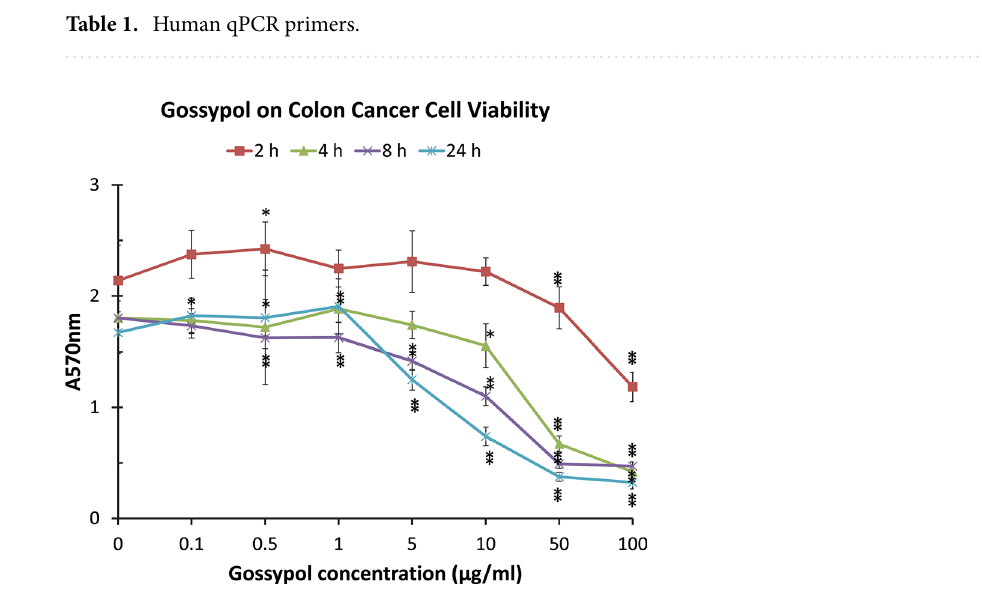
Figure 2. Effect of gossypol on human colon cancer cell viability. Human colon cancer cells (COLO 225) were treated with various concentrations of gossypol for 2, 4, 8 and 24 h. The cell media were added with MTT assay reagent, and incubated for 2 h before adding MTT solubilization solution, shaken at room temperature overnight. “0 µg/mL” treatment corresponding to 1% DMSO in the culture medium, the vehicle control for the experiment. The color density in the wells was recorded at A570. The data represent the mean and standard deviation of 12 independent samples. “*” and “**” near the data points represent significance between the treatment and the control at p < 0.05 and p < 0.01,